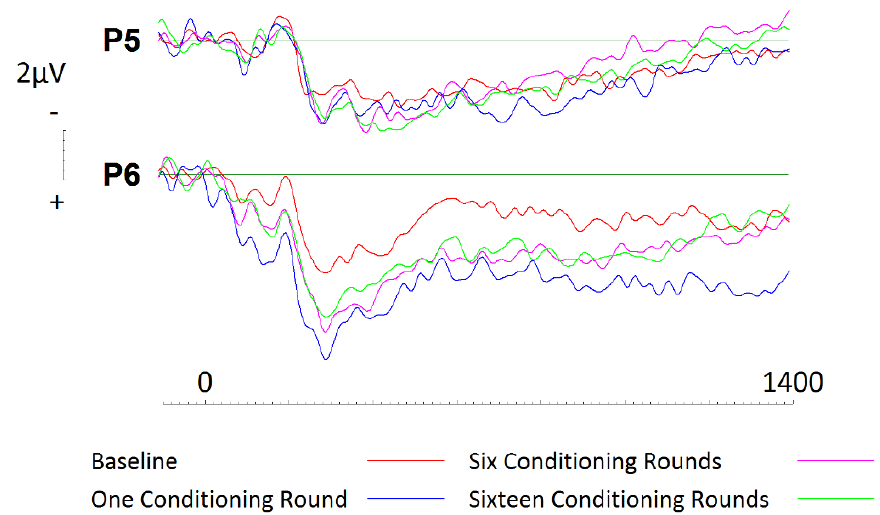
Figure 8. ERPs generated during each conditioning round for disliked brands across parietal electrode sites P5 and P6. Significant increase in cortical activity after only one round of conditioning for disliked brands across right parietal site P6.